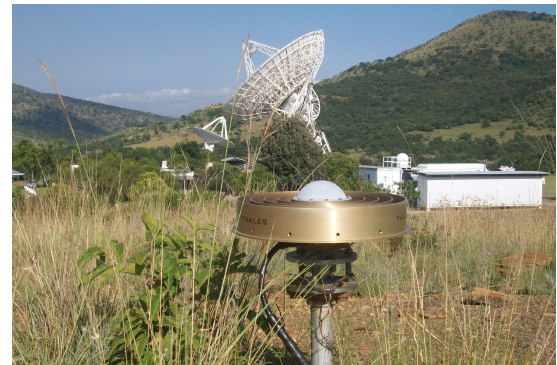
Fig. 1. Geodetic instruments collocated at HartRAO, South Africa. In the distance, 15 m VLBI antenna, 26 m VLBI antenna, SLR (MOBLAS- 6) station (centre-right) and IGS station HRAO choke-ring antenna (front centre).